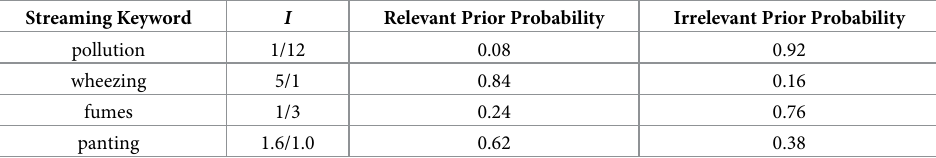
Table 14. Information gain or keyword Informativeness I of keywords, conceptualised as the ratio relevant: